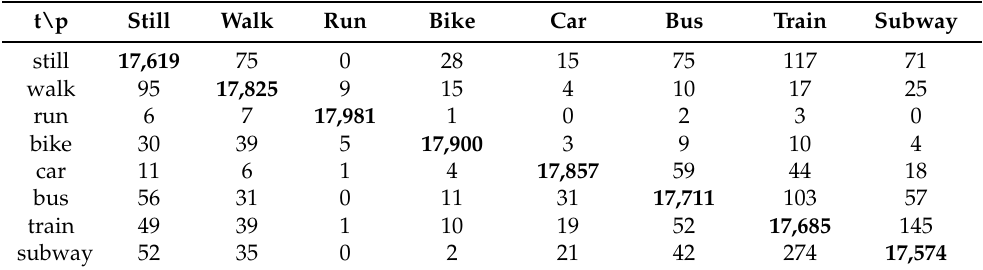
Table 3. The Confusion Matrix for the private test set. The classes with the most false classifications still and subway . The classes with the best true classifications are run and walk . t = true label, p = predicted label.